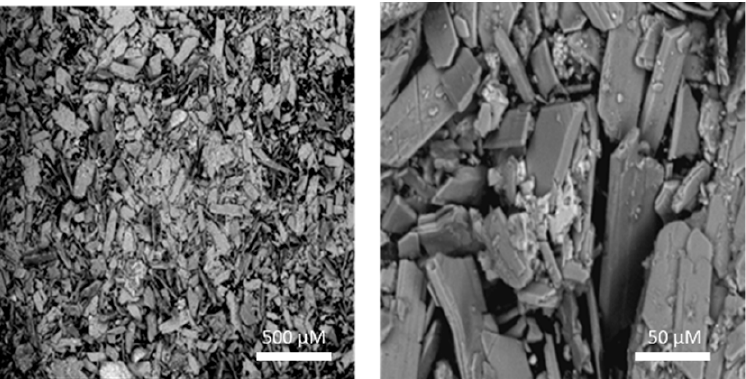
Figure 4. SEM analysis of phosphate waste before treatment at different magnifications.